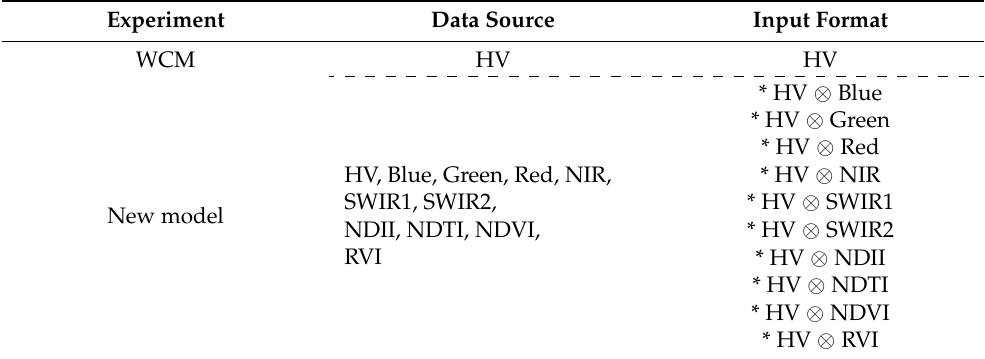
Table 2. Experimental setup in modelling FL AG .